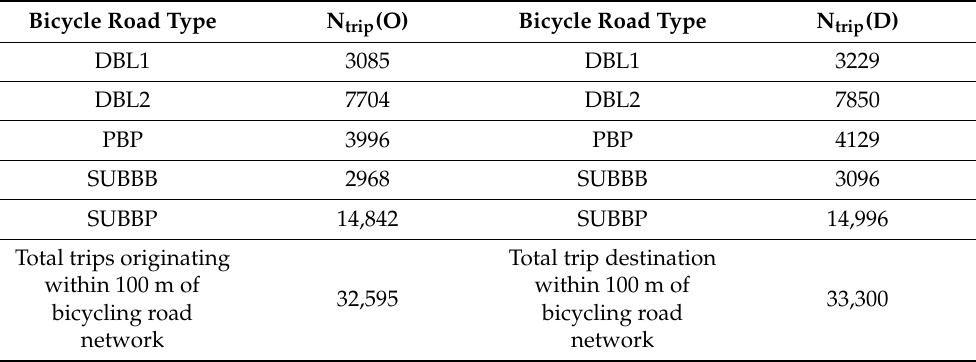
Table 3. Spatial distribution of 65,895 bicycling trip origins and destinations, within a buffer of 100 m from bicycle road infrastructure types. Source of data: BikeCitizens and Berlin Senate. Bicycle Road Type